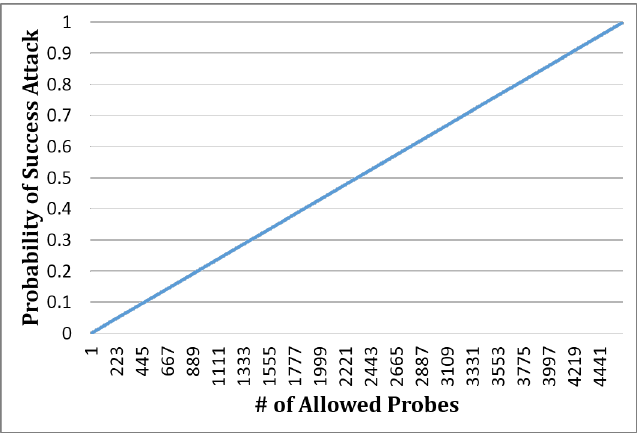
Figure 14. Probability of successful attack with different amounts of